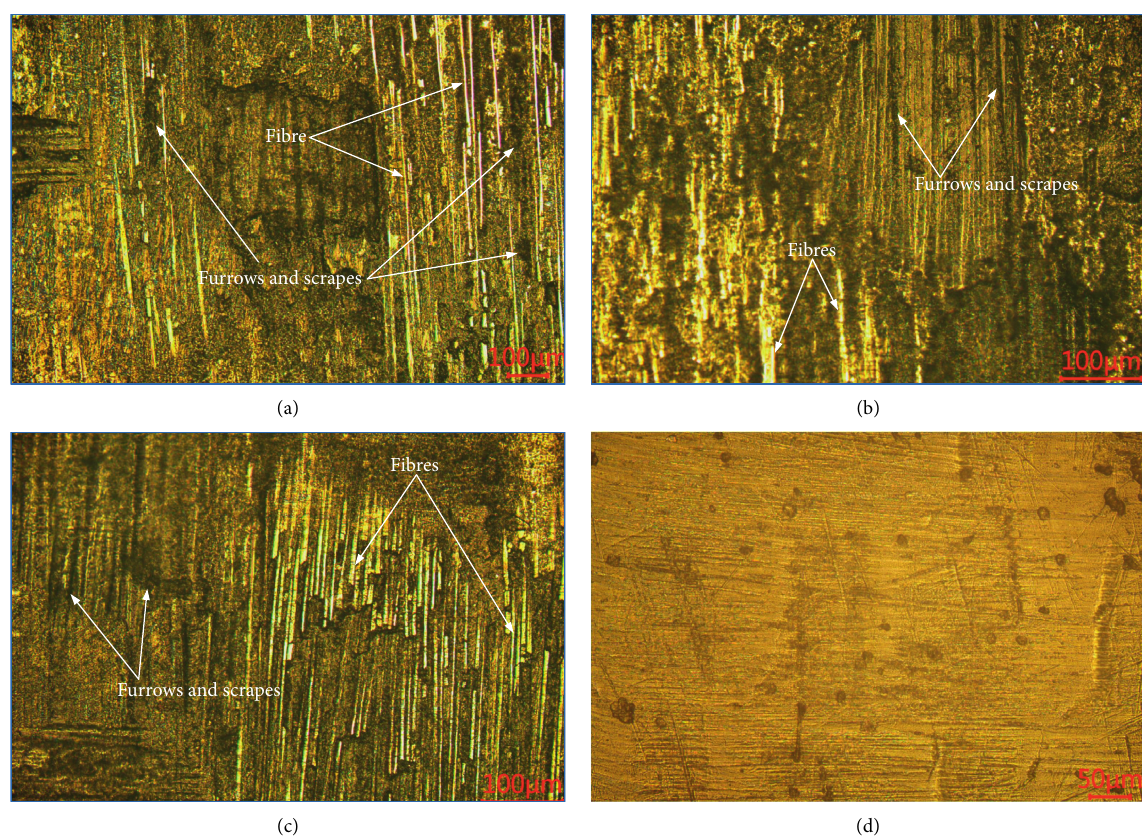
Figure 9: Microscopic morphologies of aramid/BS-4 paired with 45 steel pin under (a) 50 N, (b) 75N, and (c) 100N loads and (d) before the